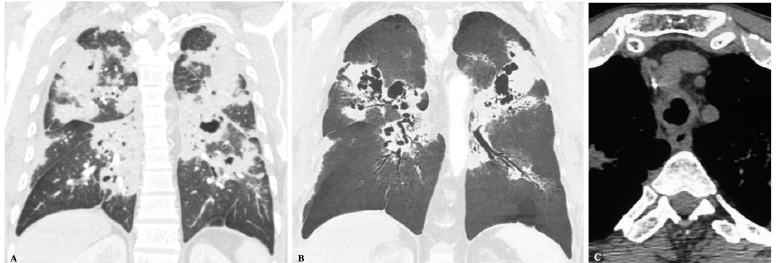
Figure 13 . 52-year-old man with paracoccidioidomycosis, presenting with a history of 1 year of shortened of breath that had worsened in the last 20 days. ( A ) coronal CT and ( B ) coronal minimum- intensity projection images depict bilateral and symmetrical consolidations and cavitations in a “butterfly wing” pattern, nodules, and ground -glass opacities. CT also reveals tracheal infection, with irregular circumferential thickening of the wall ( C ). Diagnosis was established by transbron- chial biopsy.